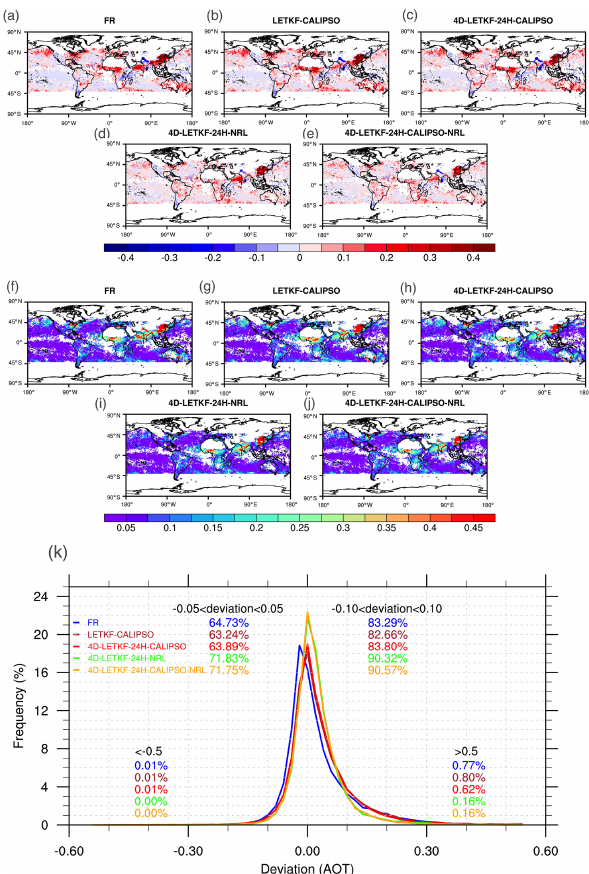
Figure 8. Spatial distributions of the biases (the simulated AOTs minus the observed ones) (a, b, c, d, e) and root mean square errors (f, g, h, i, j) between the simulated and Naval Research Laboratory (NRL) Moderate Resolution Imaging Spectroradiome- ter (MODIS) AOTs at 550nm during November 2016 for the FR, LETKF-CALIPSO, 4D-LETKF-24H-CALIPSO, 4D-LETKF-24H- NRL, and 4D-LETKF-24H-CALIPSO-NRL experiments. (k) Fre- quency distributions of deviations (the simulated AOTs minus the observed ones) from the NRL MODIS observations. The percent- ages of deviations between ± 0 . 05, ± 0 . 10, < − 0 . 5, and > 0 . 5 are also shown.